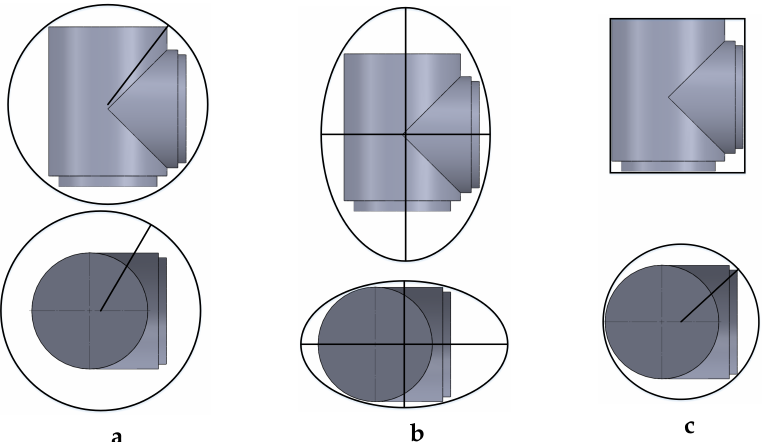
Figure 4. The basic approximate elements. ( a ) Rough spherical approximation of a motor; ( b ) Rough ellipsoidal approximation of a motor; ( c ) Rough cylindrical approximation of a